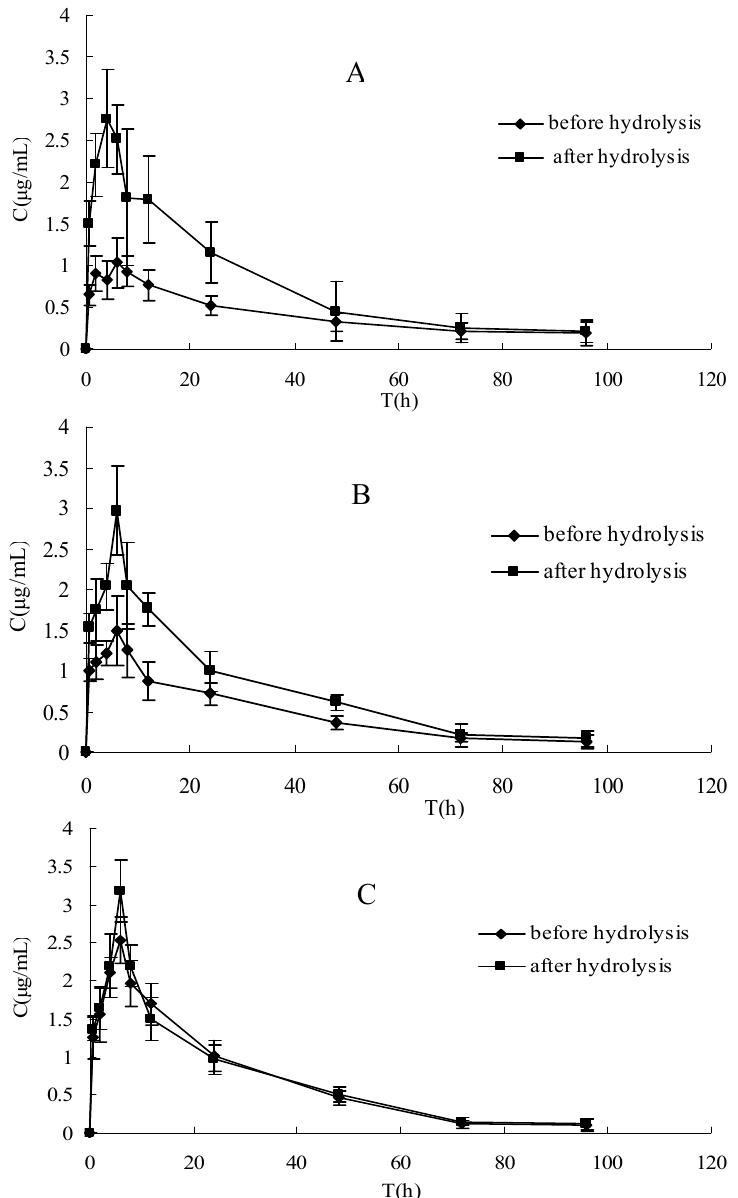
Figure 2. The pharmacokinetics profile of intact raloxifene before hydrolysis and total raloxifene after hydrolysis in different groups of rats. (A) Raloxifene alone, (B) raloxifene: apigenin = 2:1, (C) raloxifene:apigenin = 1:1. Each point represents the mean ± SD ( n =